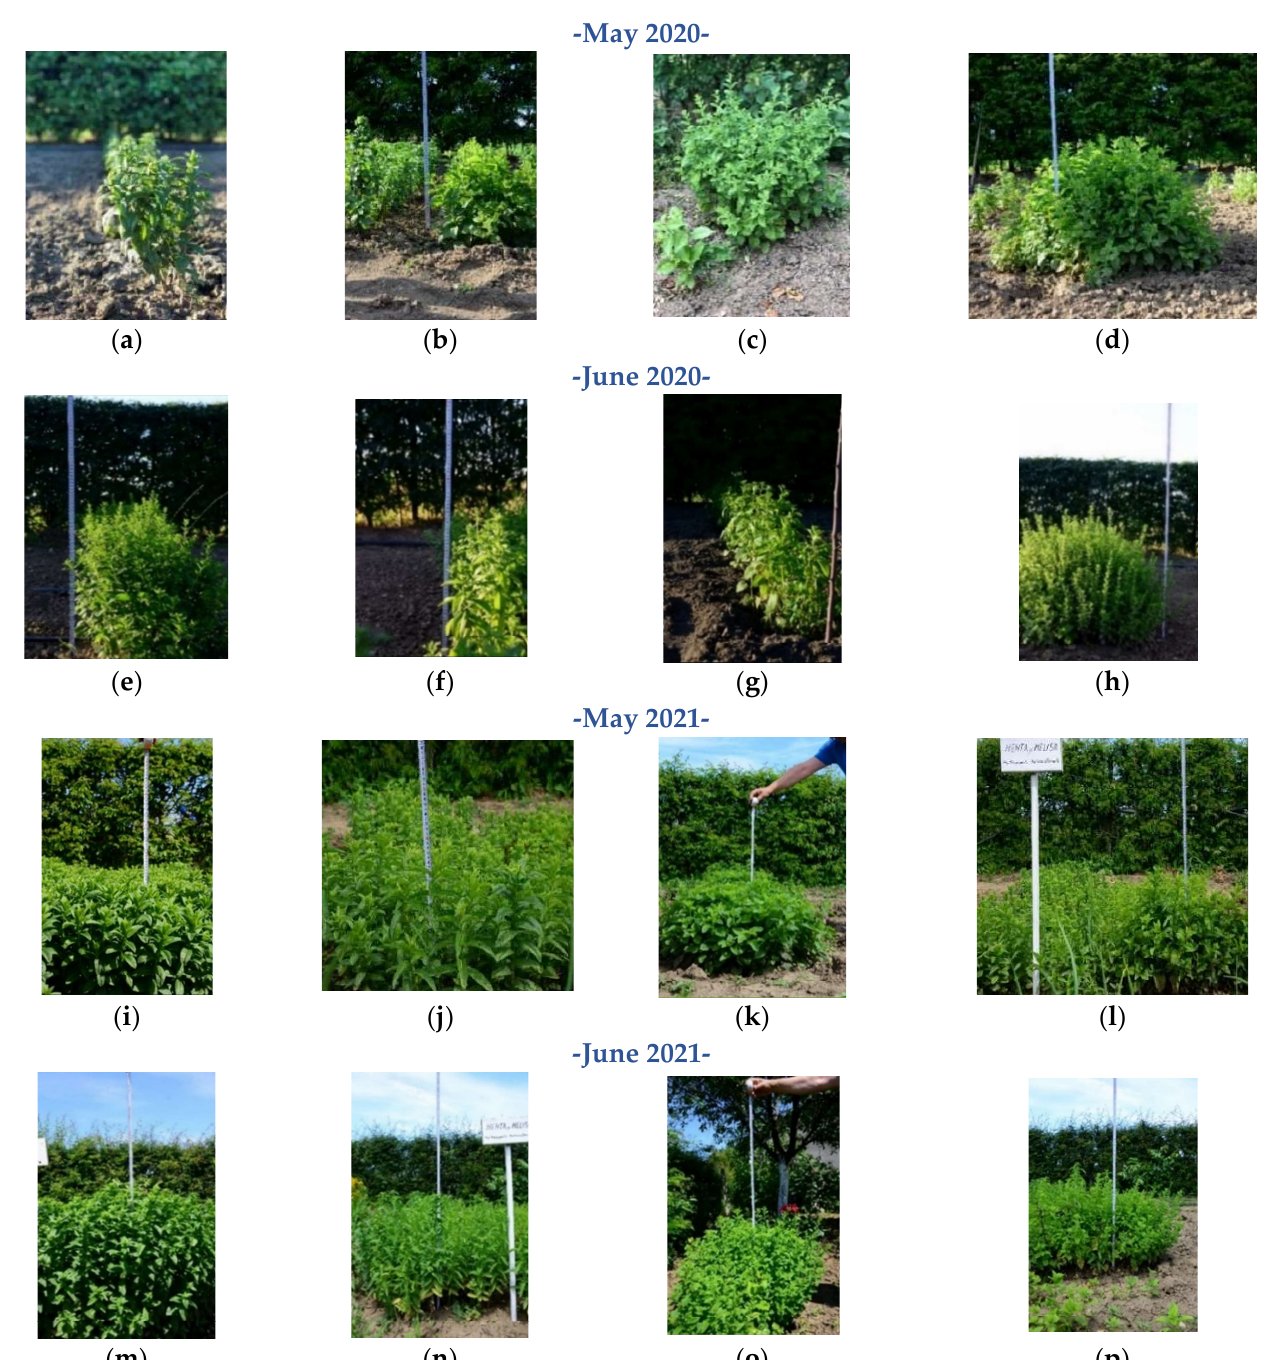
Figure 2. Evolutionary stages of Mentha piperita L. and Melissa officinalis L. growth in common crops compared with control ones during 2020–2021 ( a – p ); Legend: h—height; MM—peppermint control crop; MF—peppermint phytosociological (common) crop; MLM—lemon balm control crop; and MLF—lemon balm phytosociological (common) crop. ( a ) MM; h = 32 cm; ( b ) MF; h = 44 cm; ( c ) MLM; h = 34 cm; ( d ) MLF; h = 51 cm; ( e ) MM; h = 48 cm; ( f ) MF; h = 52 cm; ( g ) MLM; h = 55 cm; ( h ) MLF; h = 74 cm; ( i ) MM; h = 57 cm; ( j ) ML; h = 43 cm; ( k ) MLM; h = 50 cm; ( l ) MLF; h= 47 cm; ( m ) MM; h = 80 cm; ( n ) ML; h = 57 cm; ( o ) MLM; h = 70 cm; ( p ) MLF; h = 59 cm.